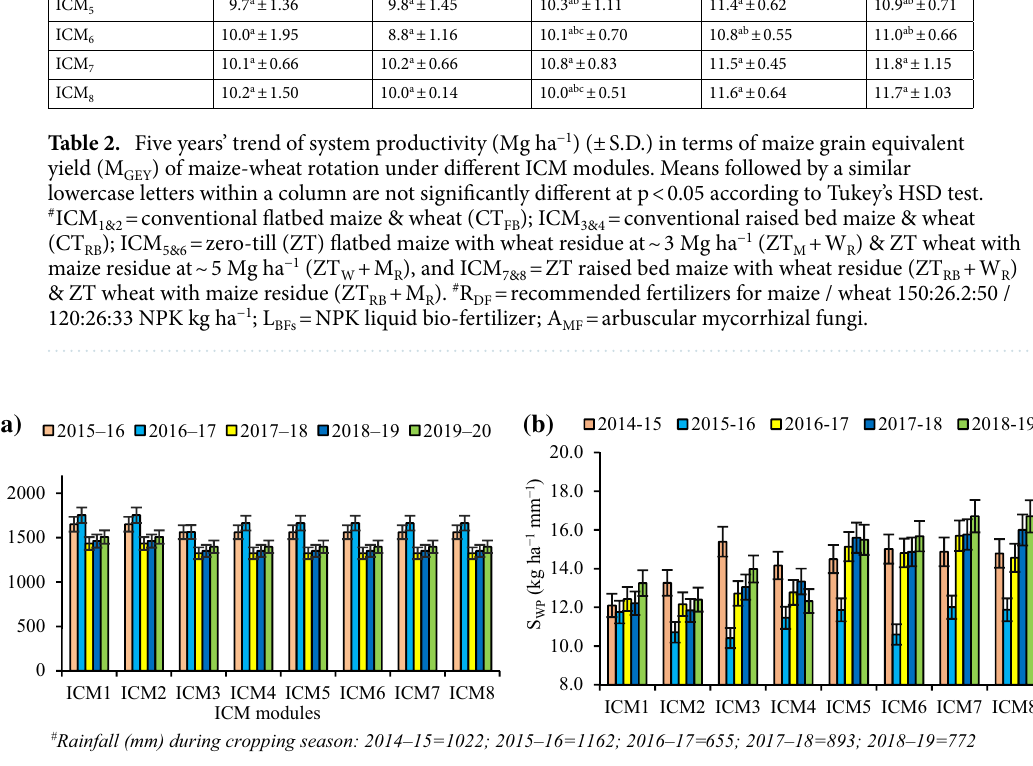
Figure 2. Five years’ water use ( a ) and system water productivity ( b ) trend under different ICM modules in maize-wheat rotation. The vertical bars indicate LSD at p =